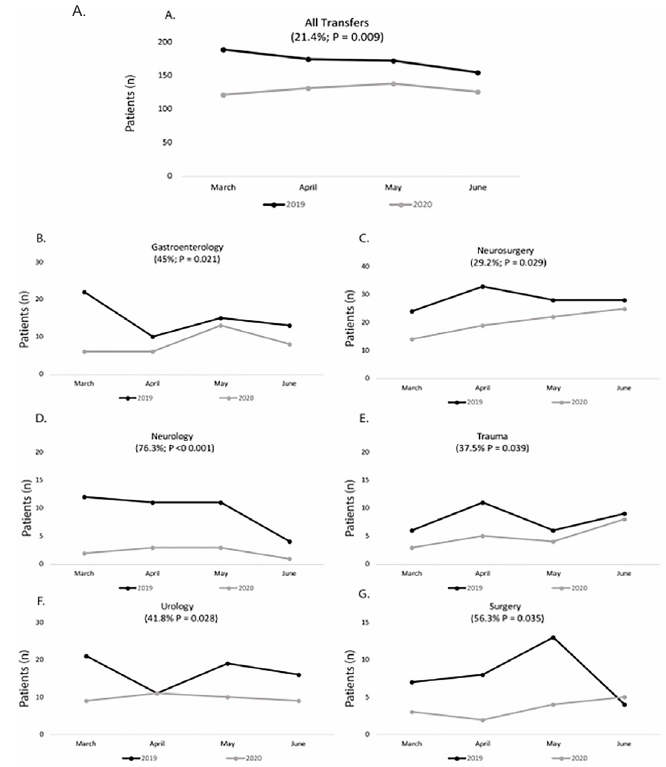
Figure. Total monthly transfers to a higher level of care (A).